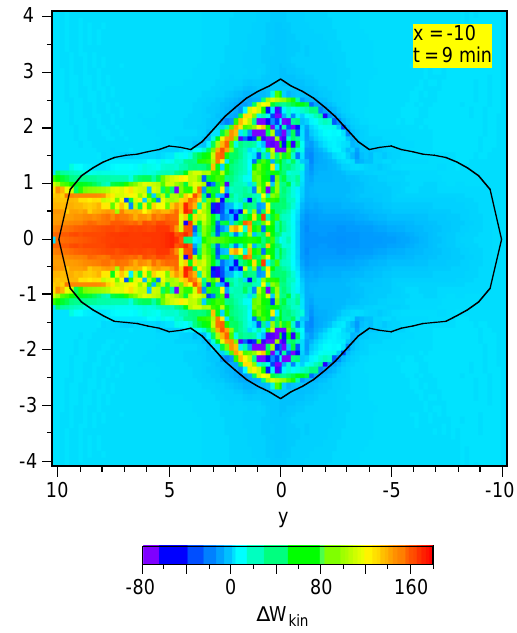
Fig. 5. Characteristics of 180keV O + fluxes in the earthward direc- tion at x =− 10 and t = 9min in a view towards the Earth with dusk to the left. The color coding again represents the energy gain of an ion traced backwards from the given location, taken as a measure of the flux increase at the given location. The black lines represent the separatrices (boundaries between closed and open field lines) at this